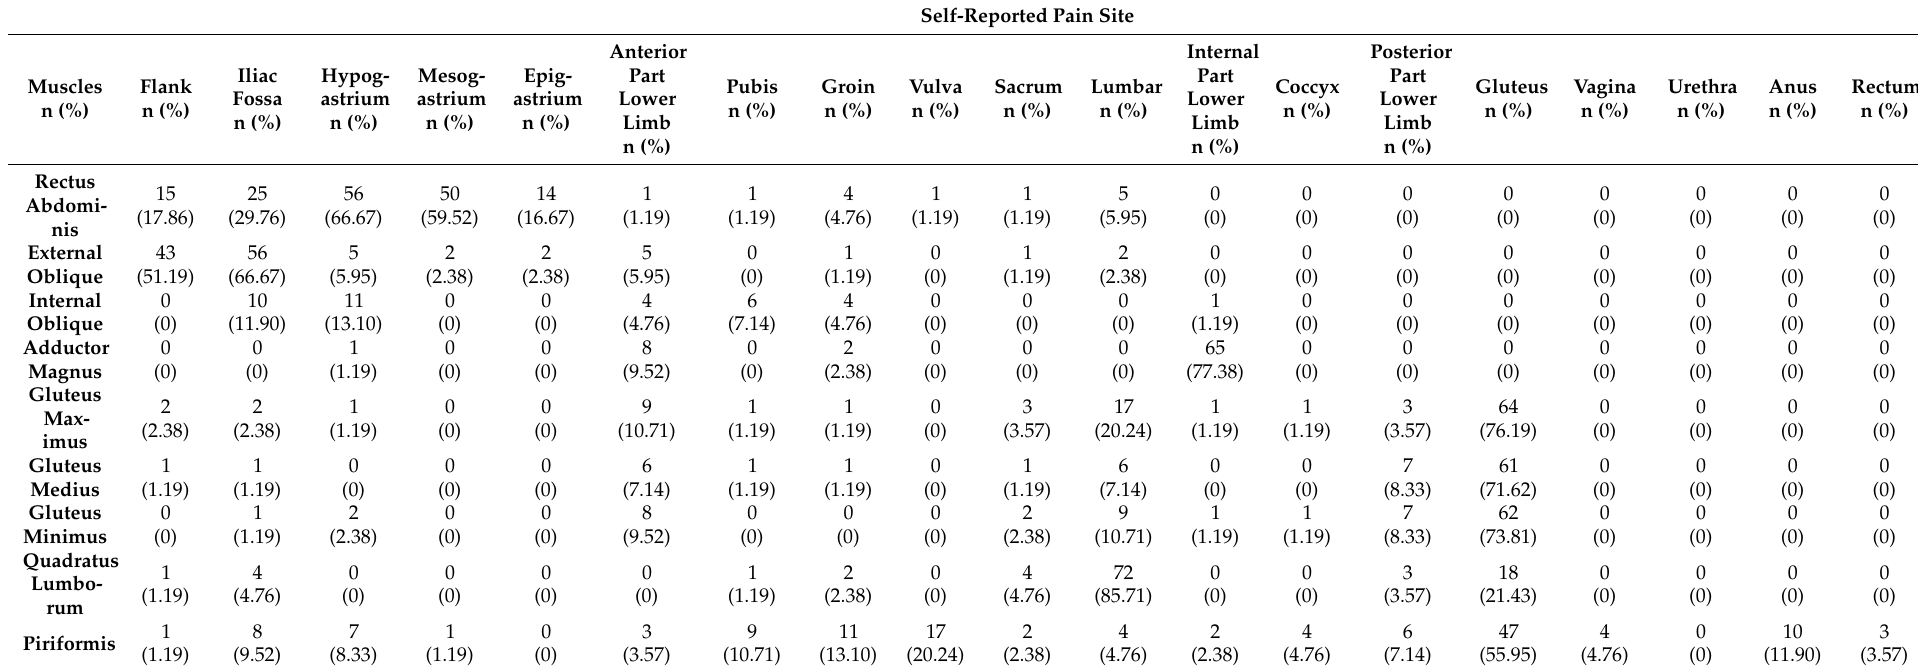
Table 10. Pain reproduced at specific sites after palpation in 84 participants during ovulatory